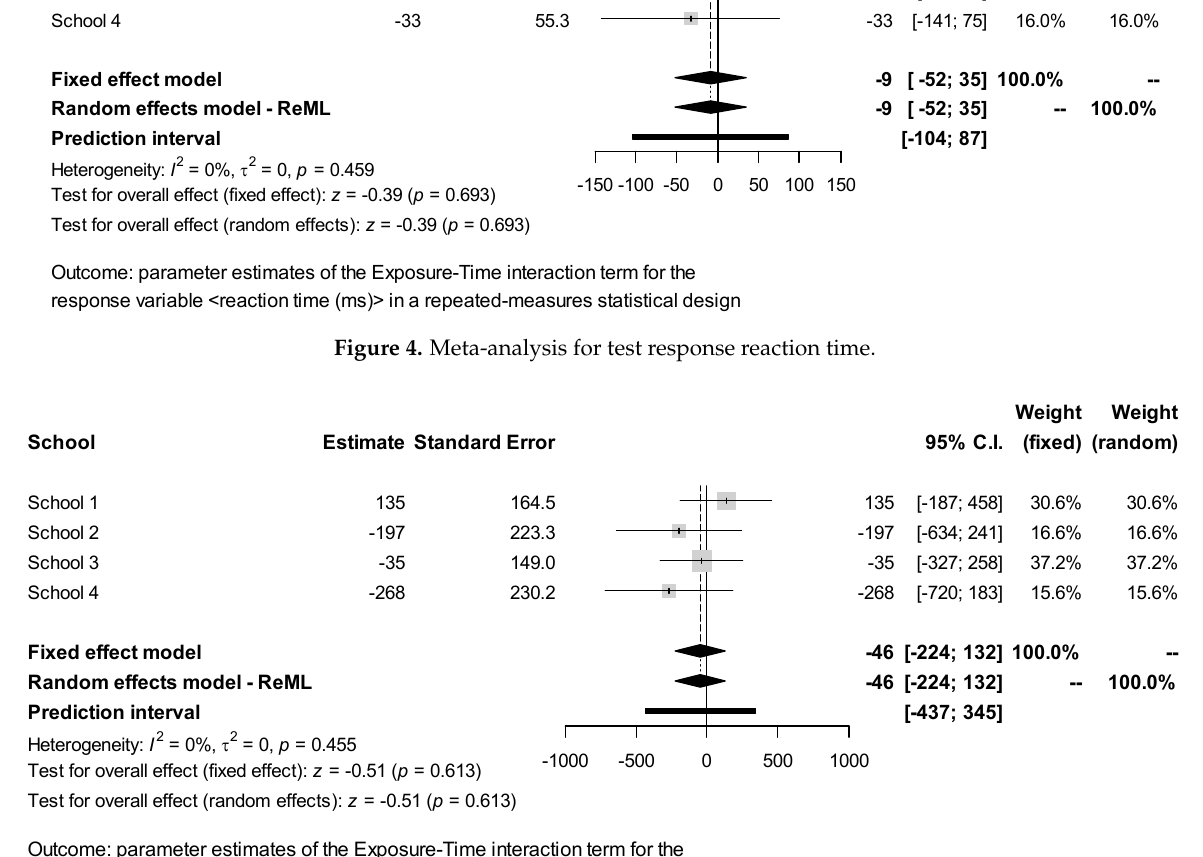
Figure 5. Meta ‐ analysis for test response impulsivity. Figure 5. Meta-analysis for test response